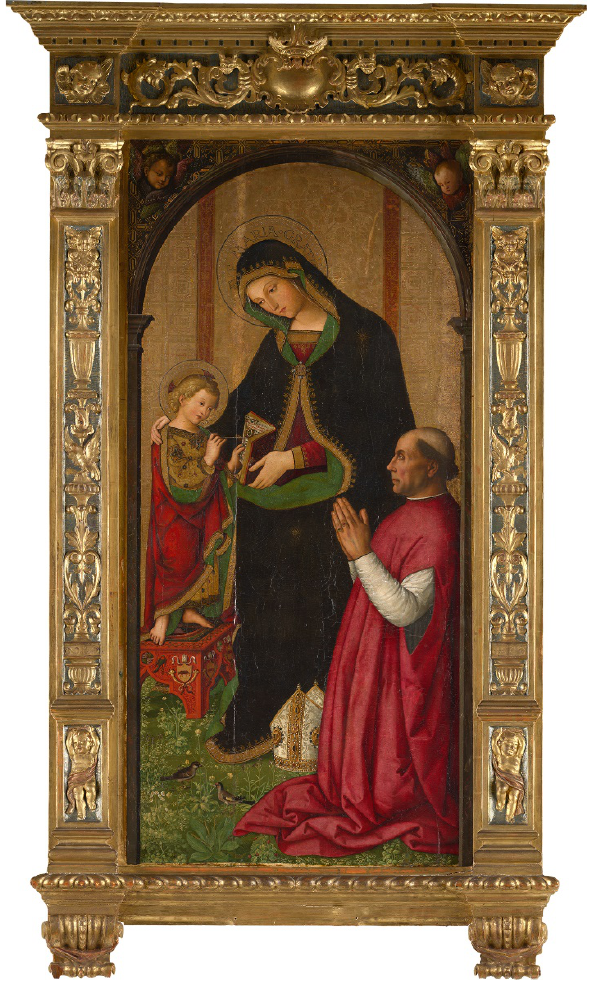
Figure 9 . Resulting gigapixel